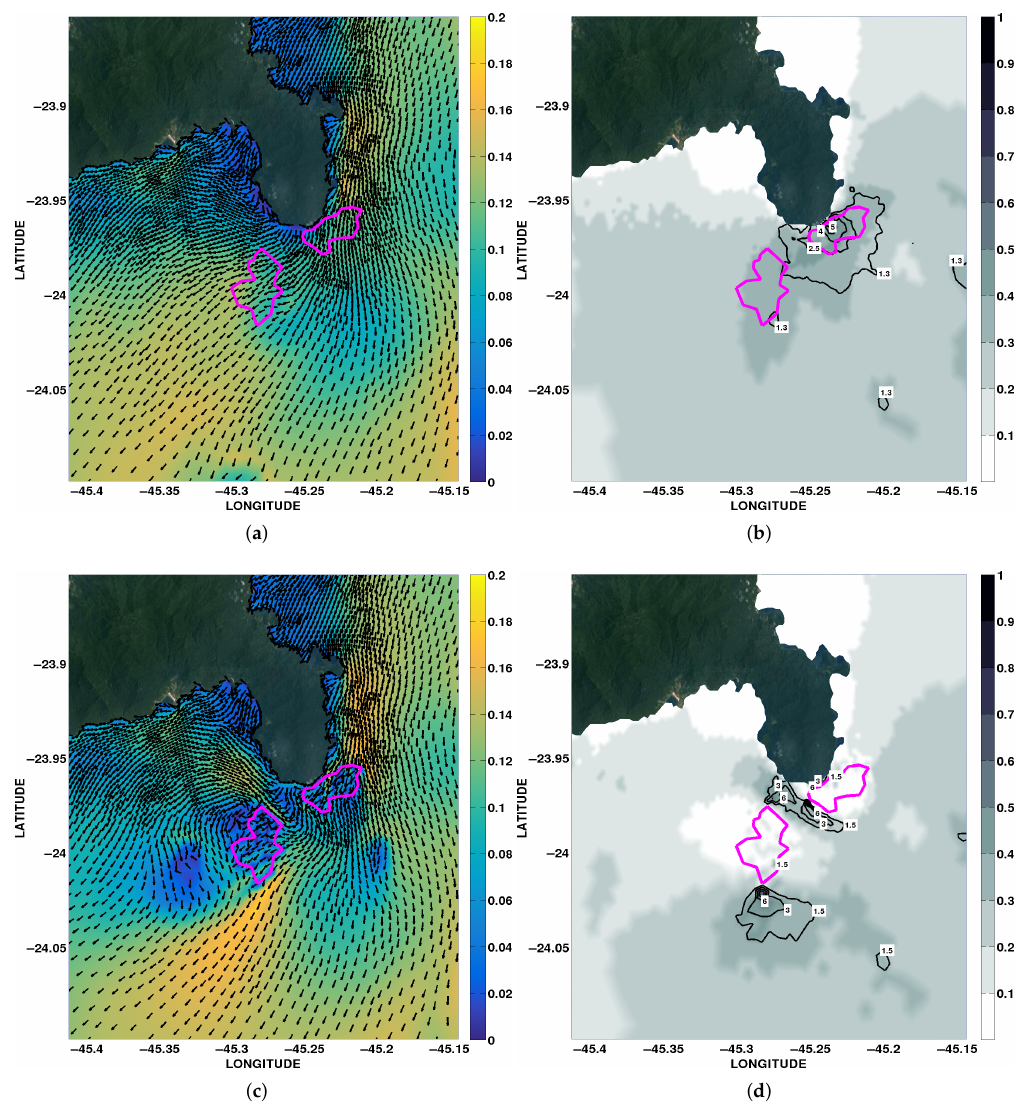
Figure 7. São Paulo turbines site. Simulation without the presence of turbines (upper panel) and with the turbines (lower panel), as the sites are represented by the magenta boundary line. ( a , c ) Mean superficial velocity (m · s − 1 ) with mean direction in vectors; ( b , d ) bed shear stress (N · m − 2 ) in black and white colormap with integrated bedload transport (cm 2 · s − 1 ) in black